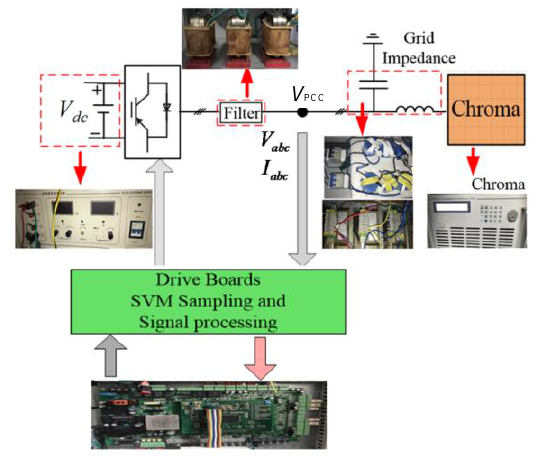
Figure 14. The structure of the experimental platform.